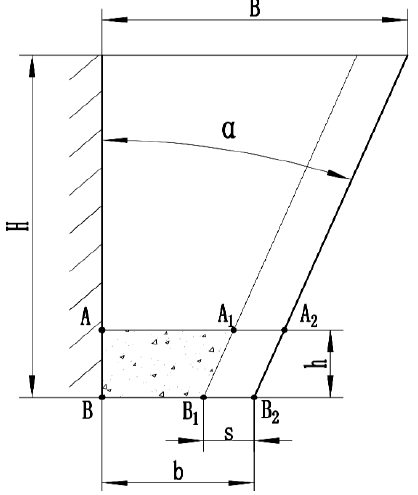
Figure 6. Cross-section diagram of the broken layer.